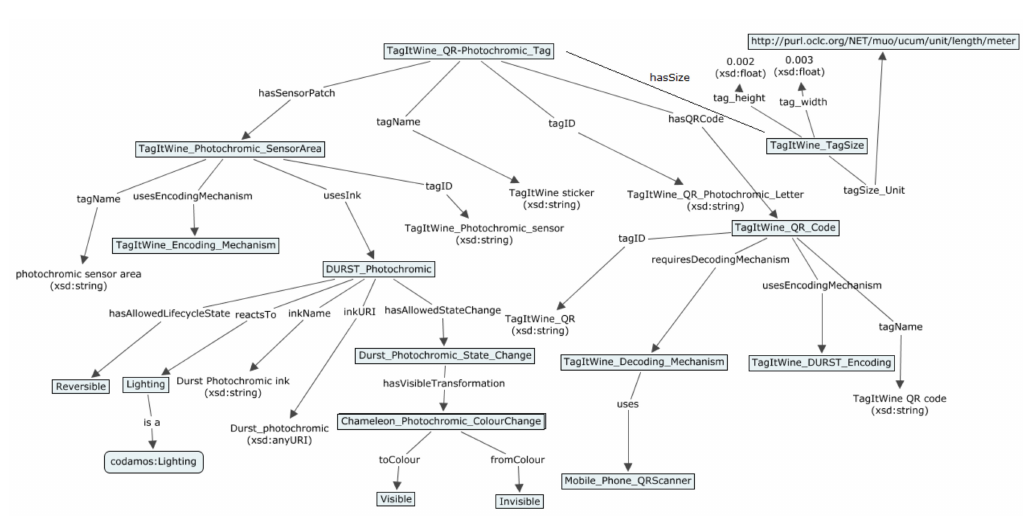
Figure 26. Semantic model for wine use